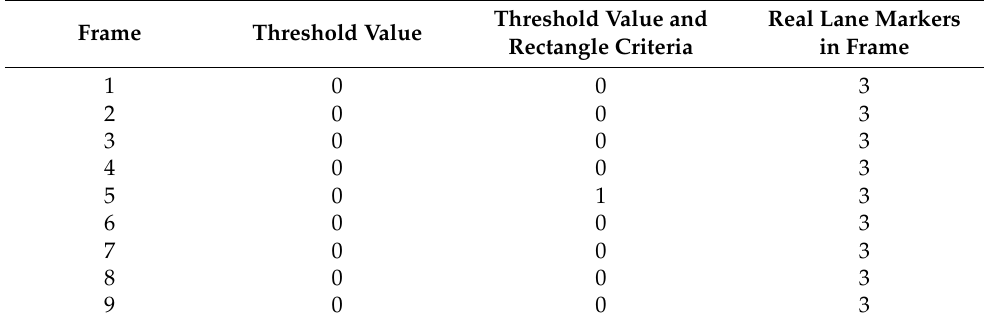
Table 3. Comparison between the number of rejected real lanes using the two presented methods. Frame Threshold Value